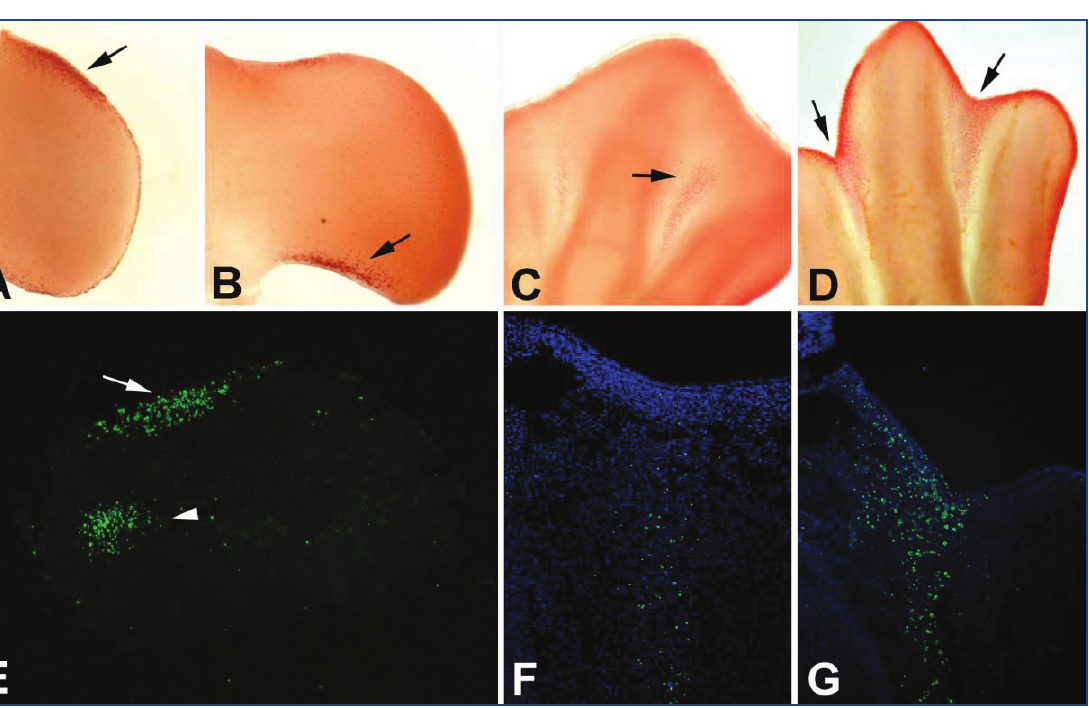
Figure 1. Regions of cell death during chicken limb development. ( A ) Hind limb bud at stage 22HH showing the anterior apoptotic zone (AAZ) (arrow). ( B ) Anterior limb bud at stage 24HH exhibiting the posterior apoptotic zone (PAZ) (arrow). ( C , D ) Cell death is observed in the interdigital apoptotic zone (IAZ) of the hind limb at stages 31HH and 32HH, respectively (arrows). Neutral red staining is shown in A – D. ( E ) Tissue section of hind limb at stage 23HH demonstrating the presence of the Patch Opaque (arrowhead) and the AAZ (arrow), which are TUNEL-positive. ( F , G ) Tissue sections from the interdigital regions of hind limbs at stages 31HH ( F ) and 32 HH ( G ) exhibiting apoptotic cells (as revealed by the TUNEL assay). In ( E ), the proximal region is at the left, and in ( F ) and ( G ), the proximal regions are at the